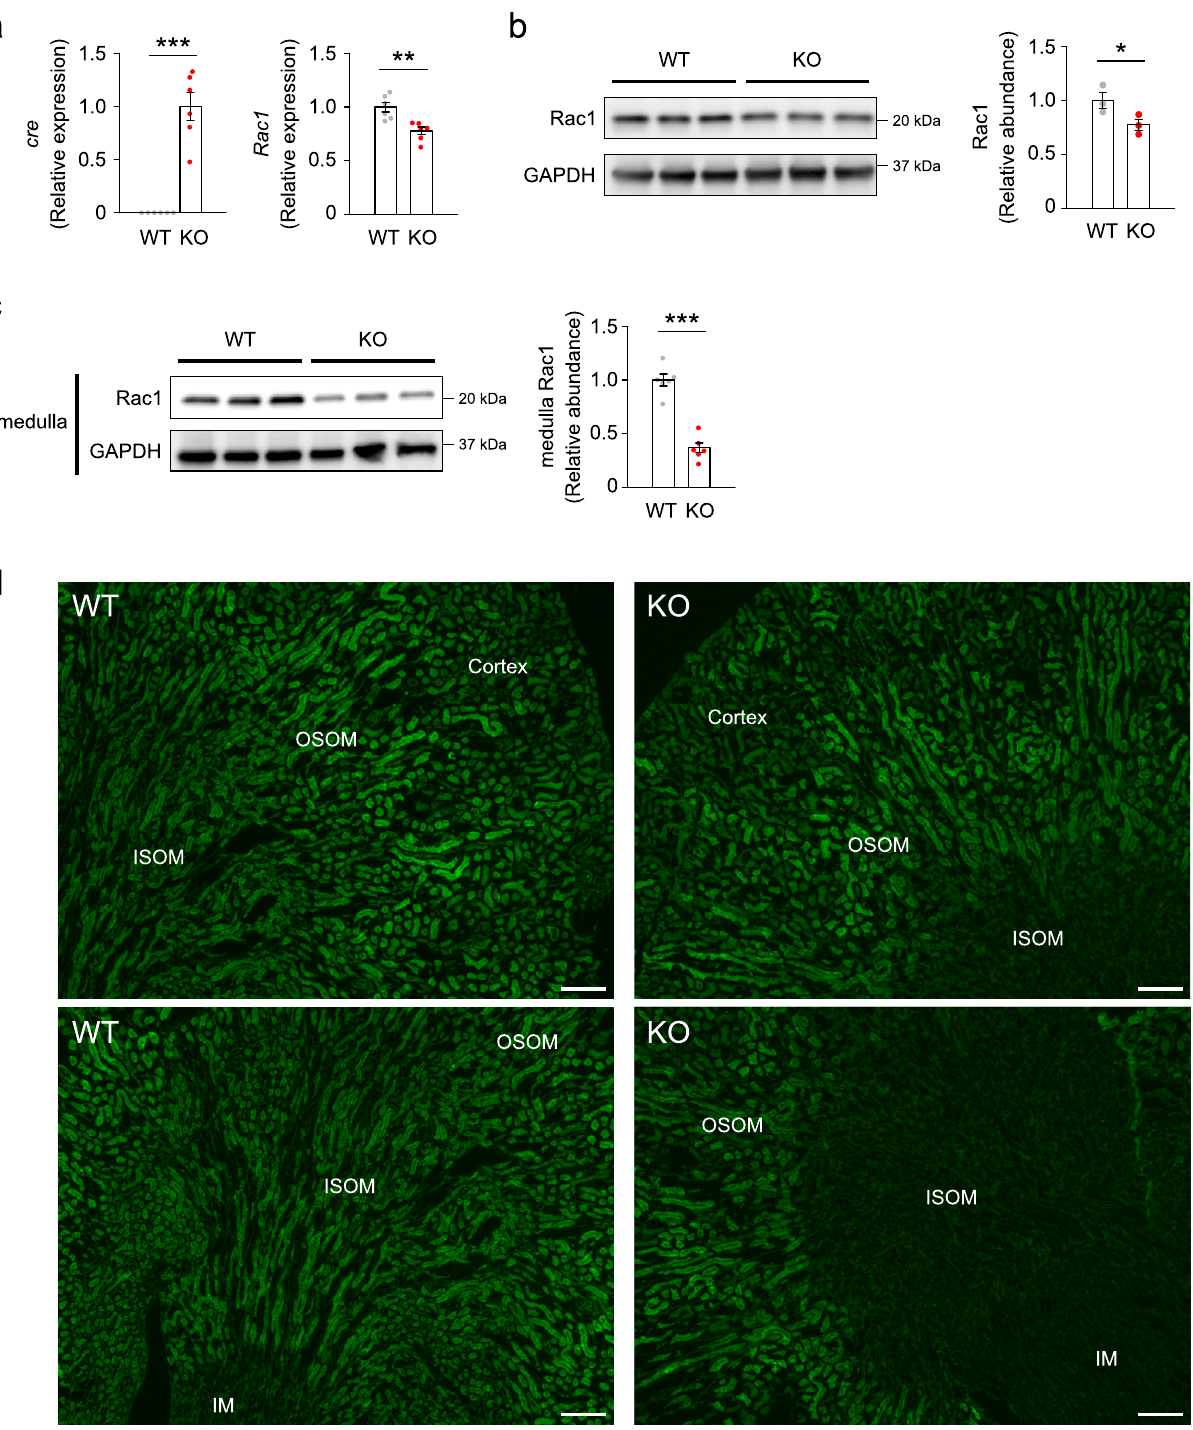
Figure 1. Loss of Rac1 in kidneys of distal tubule-specific Rac1-deficient mice at 6 weeks of age. ( a ) Quantitative analysis of cre and Rac1 gene expression in the whole kidney samples of Rac1 flox/flox mice (WT) and Rac1 flox/flox ; Ksp1.3-cre + /− mice (KO) ( n = 6 per group). The expression was normalized to a reference gene (Rps29) and reported relative to the KO group (cre) or WT group (Rac1). ( b ) Representative immunoblots and quantities of Rac1 in the whole kidney samples ( n = 3 per group). The expression was normalized to a loading control (GAPDH) and reported relative to the WT group. ( c ) Representative immunoblots and quantities of Rac1 in the renal medulla samples ( n = 6 per group). Renal medulla including papilla, which is composed primarily by the distal tubules and does not include proximal tubules, was cut out under a microscope using a thin razor blade. ( d ) Immunofluorescent staining of Rac1 (green) in the kidneys. Rac1 staining yielded negative results in the renal medulla in KO mice. OSOM: outer stripe of outer medulla, ISOM: inner stripe of outer medulla, IM: inner medulla. Scale bars, 100 μm. Data are expressed as mean ± SEM. Statistical significance was analyzed by unpaired t test. * P < 0.01; ** P < 0.01; *** P <